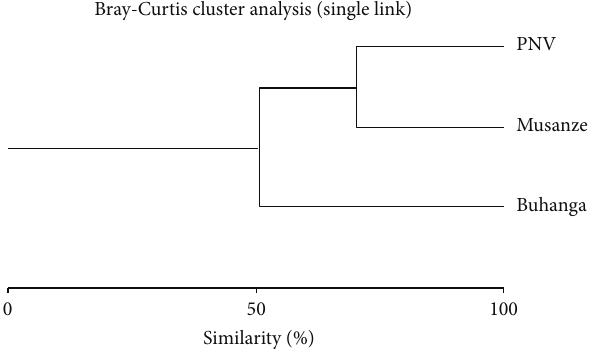
Figure 12: Musanze city, PNV, and Buhanga eco-park bird species